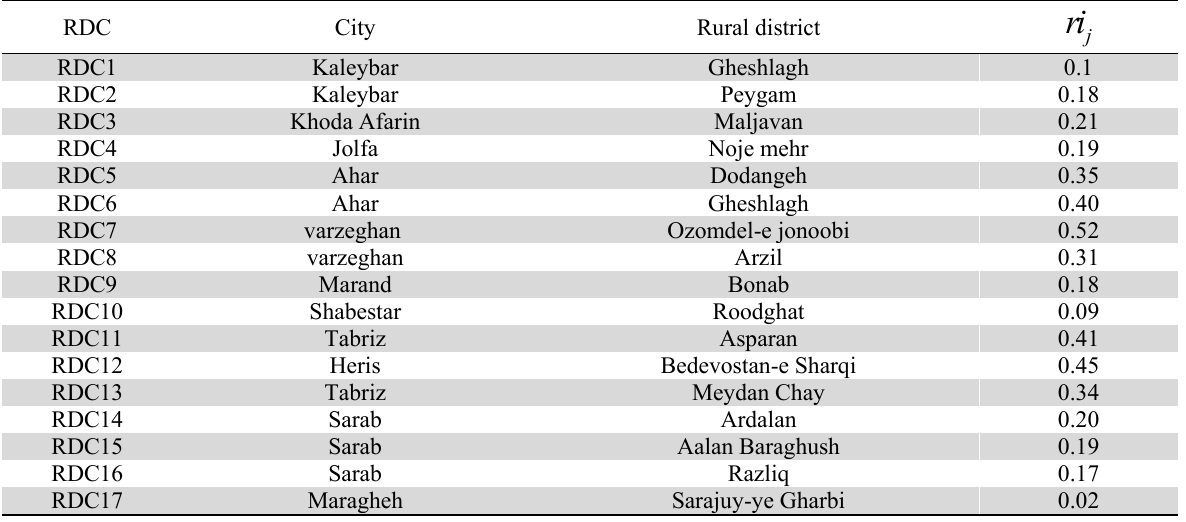
The candidate relief distribution centers for the case study